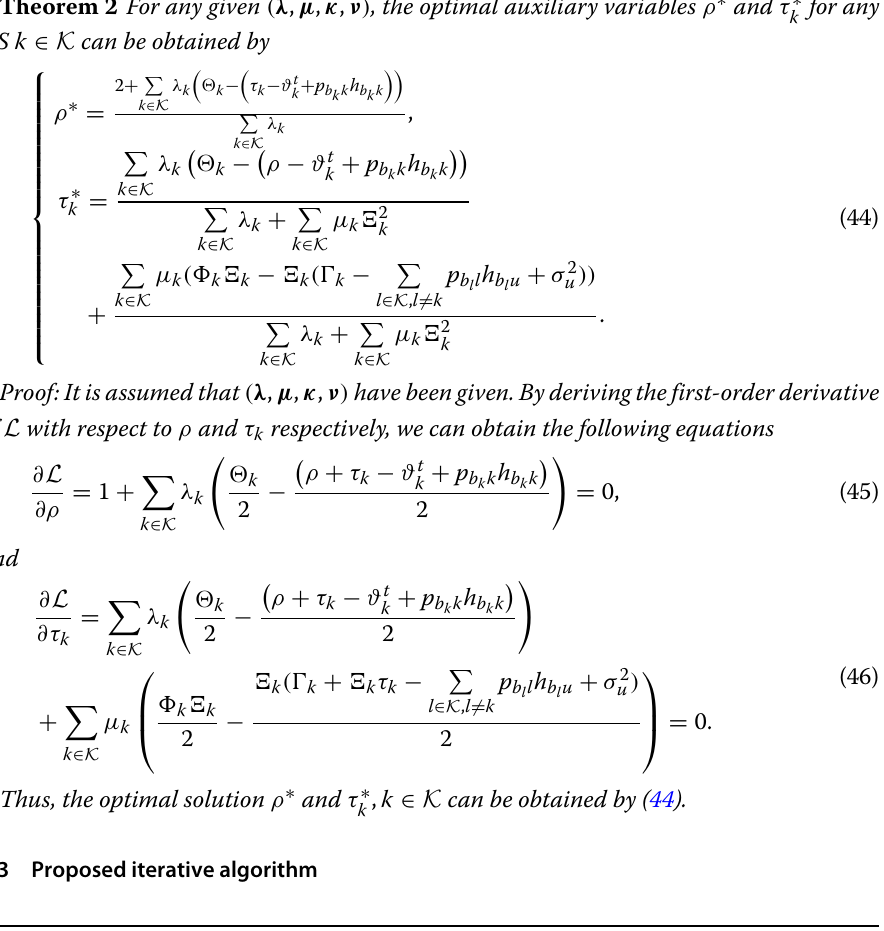
Algorithm 1 The BS-VS association algorithm for solving P